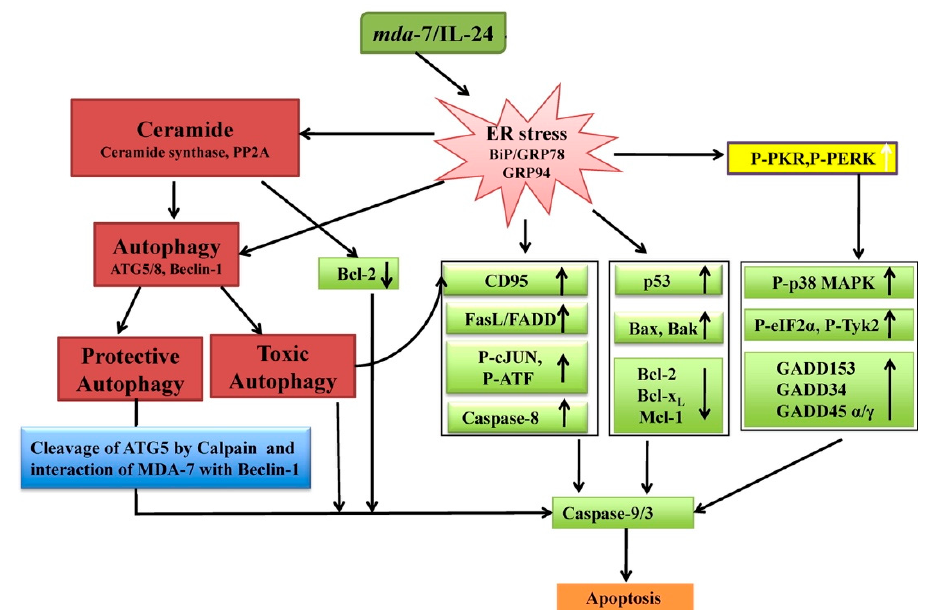
Figure 4. Model of mda-7/IL-24 -induced apoptosis in cancer cells . Outline of proposed selective cytotoxic effects of mda-7/IL-24 on cancer versus normal cells. When ectopically overexpressed, MDA-7/IL-24 localizes in the ER/Golgi compartments, regardless of the presence or absence of a secretory signal in the protein. Accumulation of MDA-7/IL-24 protein in transformed/tumor cells in this compartment triggers apoptosis, toxic autophagy and induction of ceramide that could involve induction of ER stress and/or reactive oxygen species in mitochondria. MDA-7/IL-24 activates signal transduction pathways and/or potentially enters cancer cells and activates pro-apoptotic pathways by localization and accumulation in the ER/Golgi compartment and/or by inducing mitochondrial dysfunction. A combination of pathways triggered by mda-7/IL-24 results in transformed cell-specific apoptosis (or toxic autophagy). Adapted by permission from Dash et al., 2010 [55].